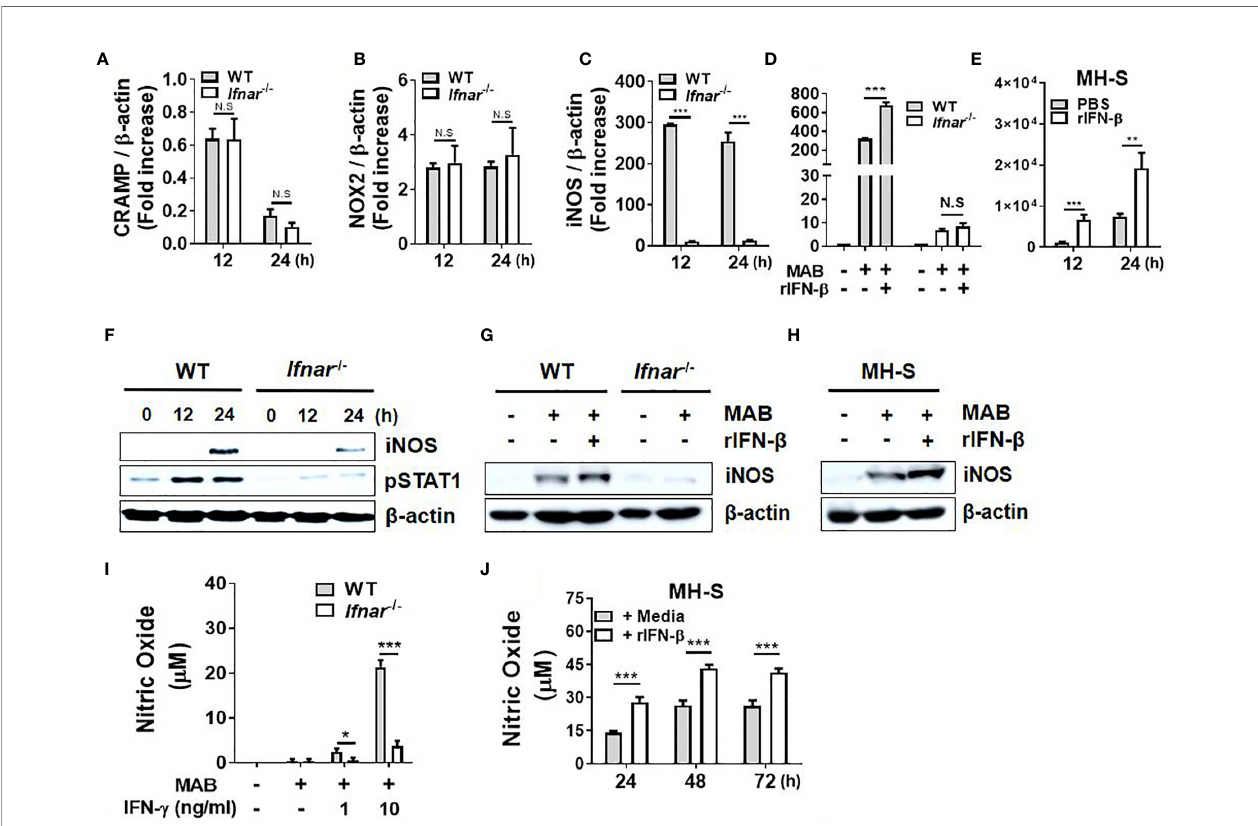
FIGURE 2 | Type I IFNs augment MAB-induced production of nitric oxide in macrophages. (A – C) WT and IFNAR-de fi cient BMDMs were infected with MAB at a MOI 1:25 for indicated times. (D, E) BMDMs and MH-S cells were pretreated with or without rIFN- b (1,000 units/ml) for 2 h and additionally infected with MAB for (D) 12 h or (E) indicated times. (A – E) mRNA was extracted, and the expression levels of each gene were determined by real-time PCR. (F) BMDMs were infected with MAB for indicated times. (G) BMDMs and (H, J) MH-S cells were pretreated with or without rIFN- b (1,000 units/ml) for 2 h and additionally infected with MAB for (G, H) 24 h or (J) indicated times. (I) BMDMs were incubated for 24 h with indicated conditions. (F – H) Cellular proteins were extracted, and the levels of indicated proteins were determined by Western blotting. (I, J) Nitric oxide concentration in cell culture supernatant was measured by Griess reaction. (A – J) The results are from one representative experiment of two independent experiments (*p < 0.05, **p < 0.01, ***p < 0.001). MAB, Mycobacterium abscessus ; IFN, interferon; WT, wild type; IFNAR, interferon- a / b receptor; BMDMs, bone marrow-derived macrophages; MOI, multiplicity of infection. NS, Not Statistically Signi fi